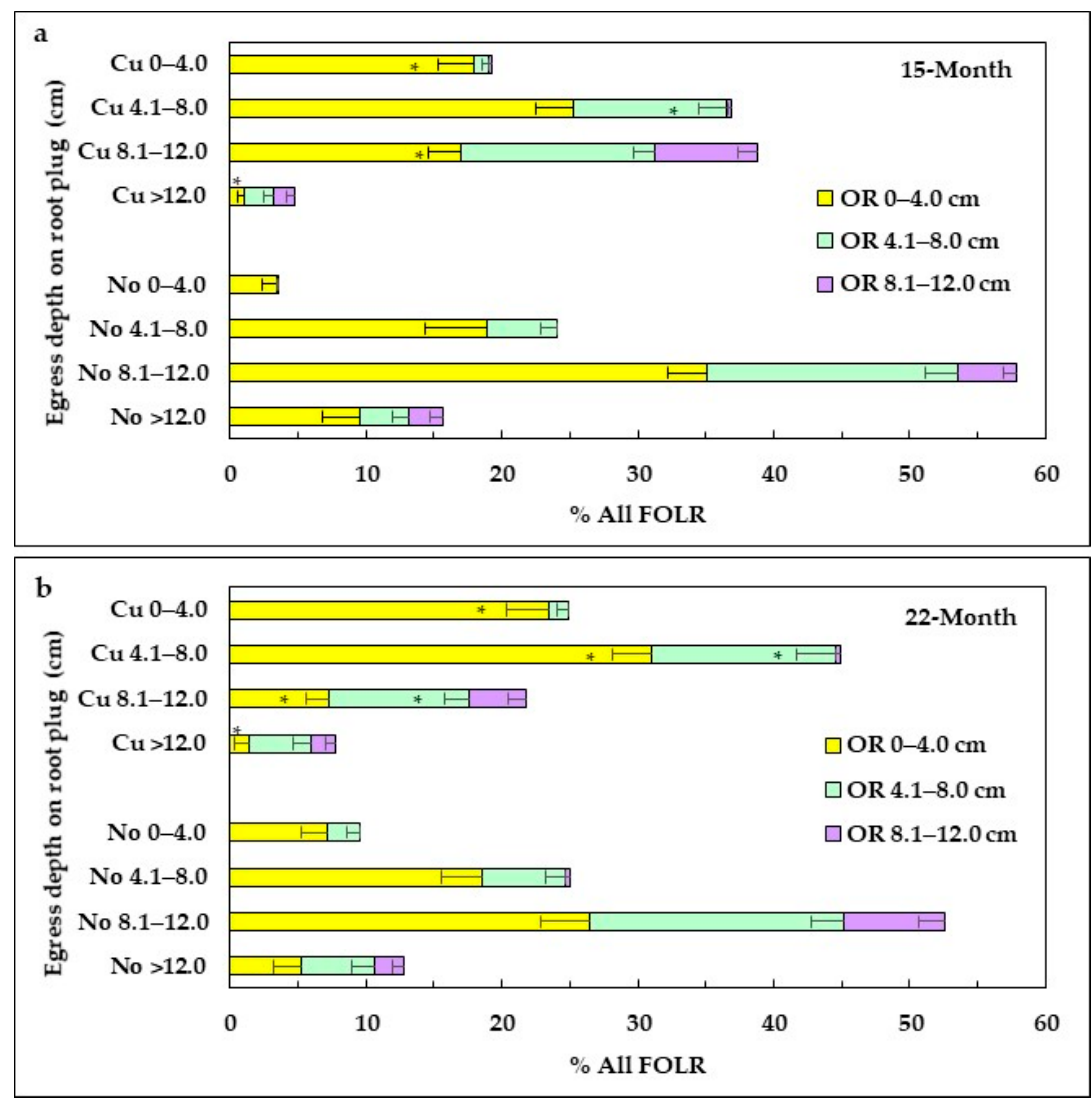
Figure 5. Percent first-order lateral roots (FOLRs) originating from each zone of the taproot (OR 0–4.0, 4.1–8.0, and 8.1–12.0 cm) and egressed from each of the four root plug zones (0–4.0, 4.1–8.0, 8.1–12.0, and >12.0 cm) in response to Cu root pruning among longleaf pine seedlings. ( a ) 15 months after outplanting; ( b ) 22 months after outplanting. Within a root plug zone and excavation, asterisks associated with Cu seedlings indicate that Cu root pruning significantly changed percent FOLR egress at the Bonferroni-adjusted 0.05 level. Error bars represent 1 SE.